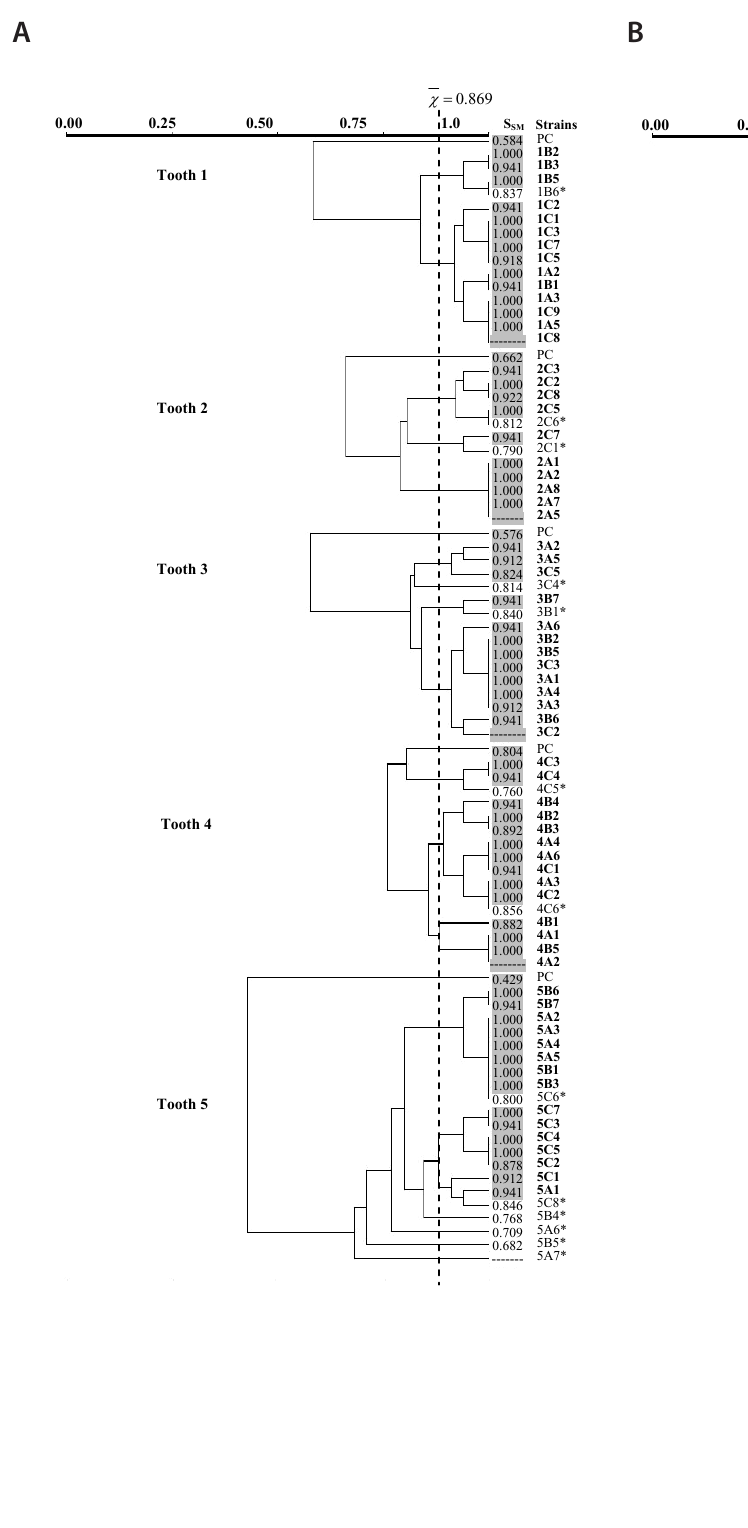
Figure 1. Genetic similarity indices (AP-PCR method, primer OPA-13) verified among S. mutans strains sampled from caries lesions of each teeth, submitted to indirect pulp treatment. A: dendrograms obtained to isolates of teeth 1 to 5. B: dendrograms obtained to isolates of teeth 6 to 10. Individual bands were analyzed by matrices generated by UPGMA analysis using coefficient SSM (simple matching). Tonalities of gray in the dendrograms illustrate identical or highly related isolates (S ≥ 0,869) found in each tooth. * Different genotypic patterns obtained in each tooth (S SM